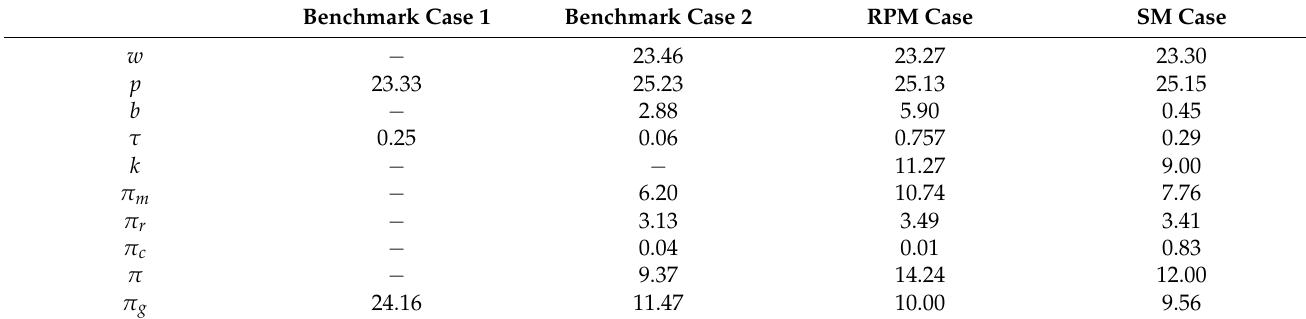
Table 2. The four cases’ decision-making outcomes and firm’s